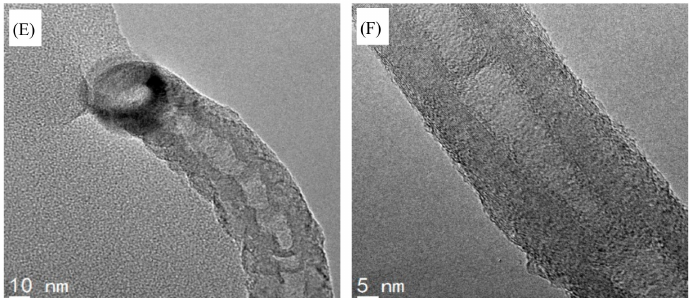
Figure 4. Scanning electron microscopy (SEM) images of the N-CNT arrays grown on one side surface of carbon-black layer / carbon paper substrate: ( A ) Whole micromorphology, ( B ) high magnification image, ( C ) initial stage growth, and ( D ) cross-sectional view of N-CNT array. ( E , F ) High magnification transmission electron microscopy (TEM) images of the N-CNTs in the